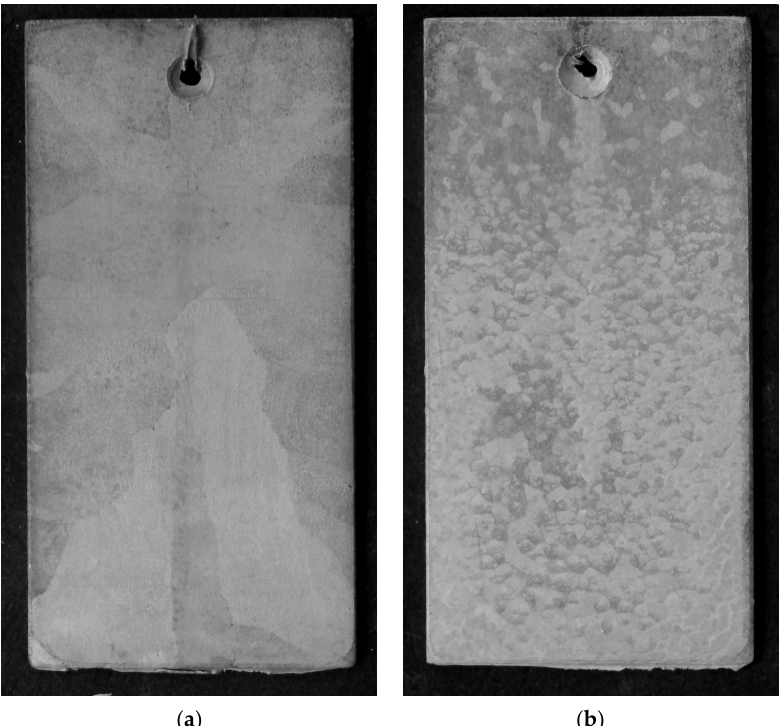
Figure 8. The view of the surface of zinc coatings obtained in: Zn-AlNiBi ( a ) and pure zinc ( b ) [17] baths after 30 test cycles in a sulfur dioxide test in the humid atmosphere.